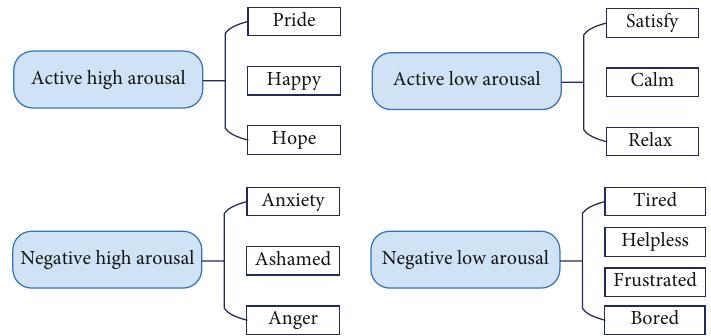
Figure 2: The speci fi c manifestations of the academic emotions in four dimensions.